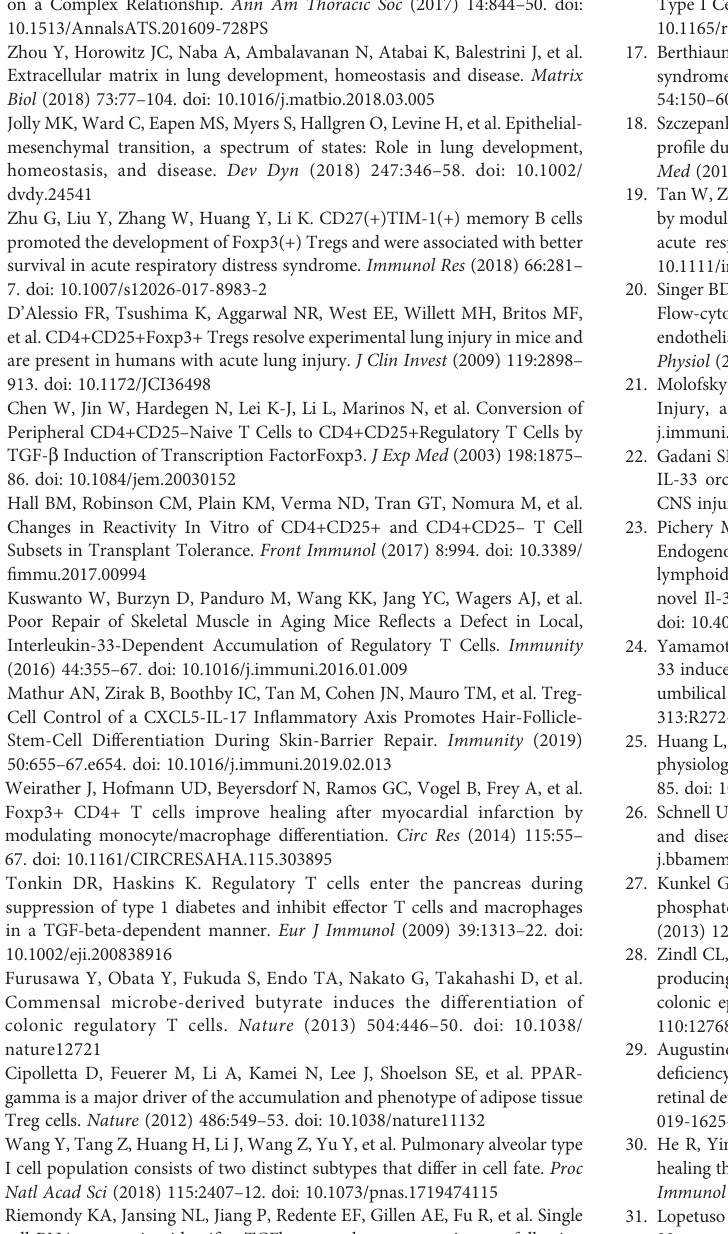
Supplementary Figure 1 | identi fi cation of IL-33 localization in AEC2s. Variation in the colocalization of IL-33-producing AEC2s within days: immuno fl uorescence